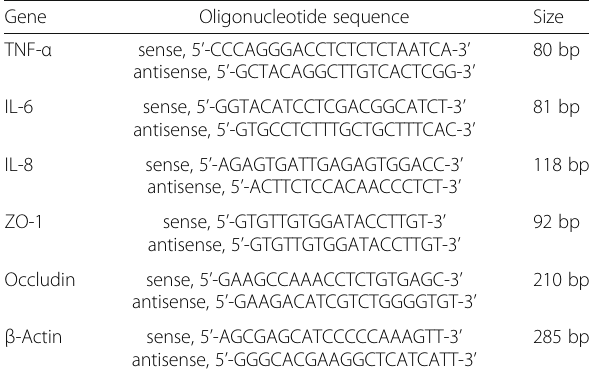
Table 1 Real-time PCR primer sequences Gene Oligonucleotide